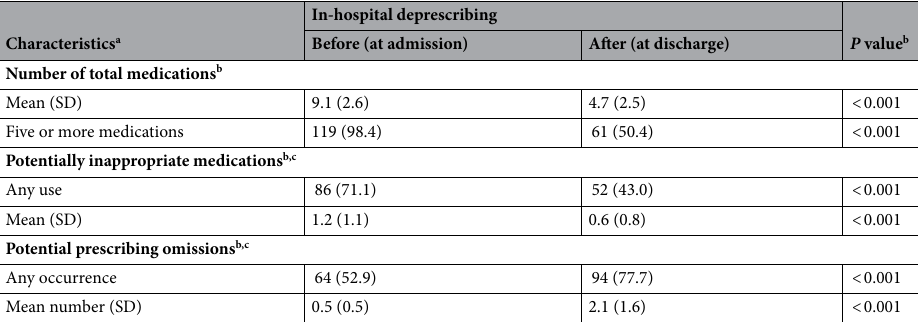
Table 2. Change in the numbers of all medications, PIMs, and PPOs after the in-hospital deprescribing intervention. COPD chronic obstructive pulmonary disease, PIM potentially inappropriate medication, PPO potential prescribing omission, SD standard deviation. a Values are expressed as the number with the percentage of the total number, unless otherwise stated. b Comparisons between the time at admission and discharge were performed by using Fisher’s exact test and Student’s t-test for categorical and continuous variables, respectively. The level of statistical significance was set at 5%. c Based on the 2015 STOPP/START criteria.